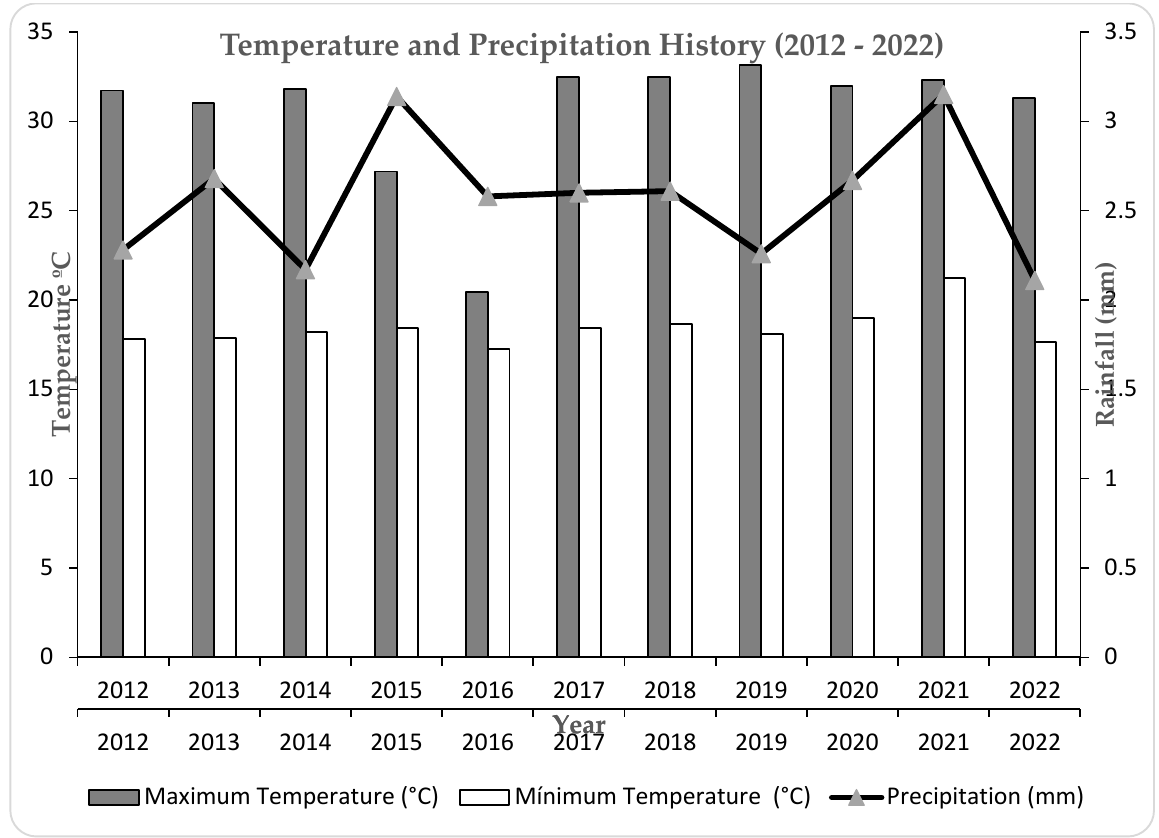
Figure 1. Rainfall distribution (mm) and mean temperatures (°C) during the experimental period in the study area.